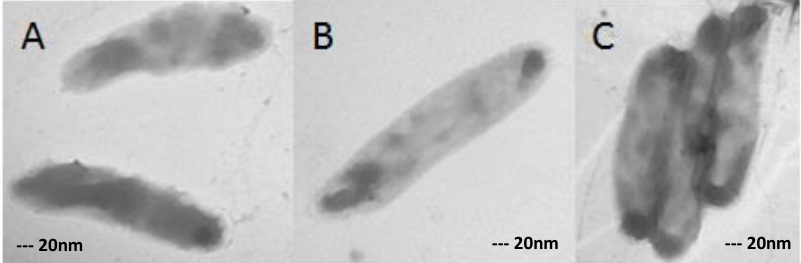
Figure 2. XDR-TB controls (XDR cells grown in medium without any antibiotic) in single ( A and B ) and in flock ( C ). Magnification: 40,000×.